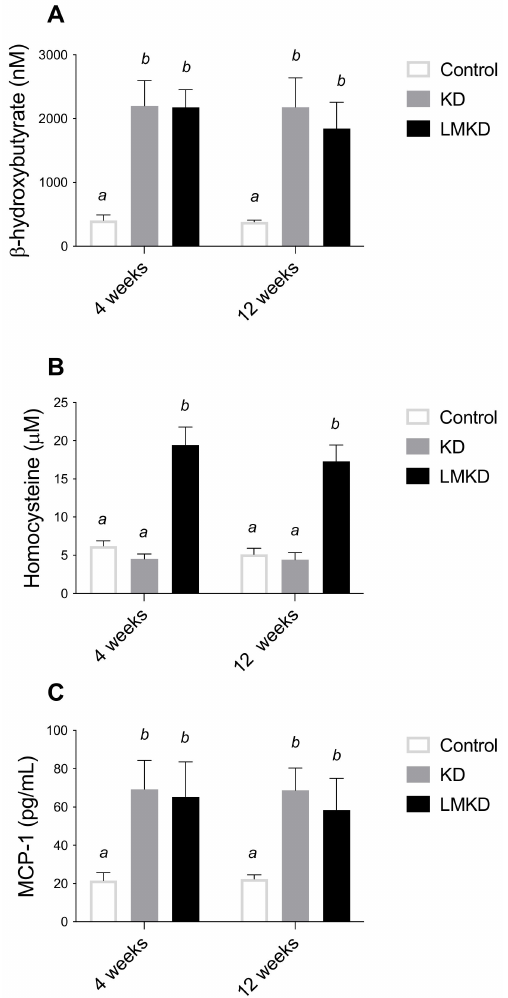
Figure 2. The effect of the experimental diets (ketogenic diet, KD; low methyl ketogenic diet, LMKD; and control) on the plasmatic concentrations of β -Hydroxybutyrate ( A ), homocysteine ( B ) and monocyte chemoattractant protein-1 (MCP-1) ( C ). Data shown are the mean ± SD, n = 4–6/group. Means not sharing superscript letters differ by p <